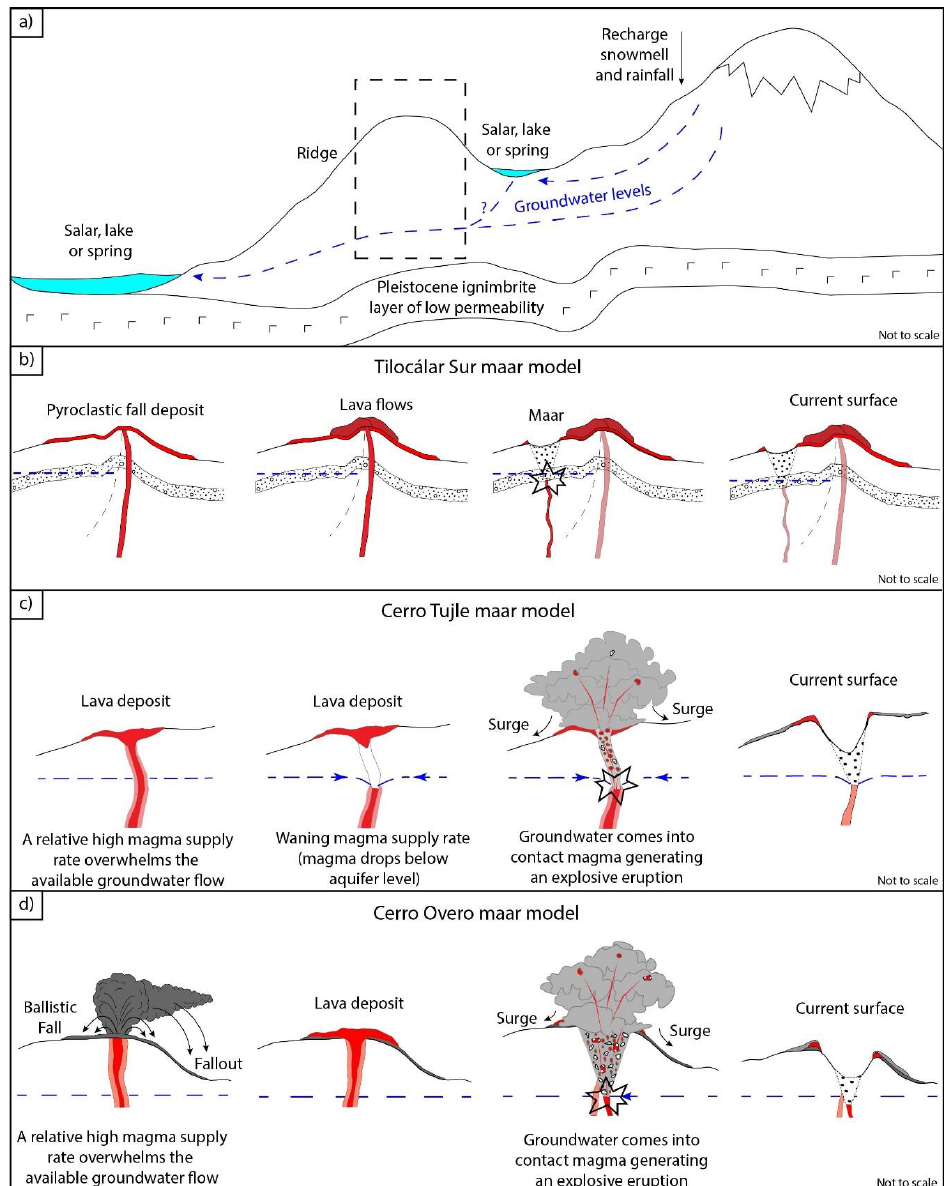
Figure 10. Proposed model of the mechanism of maar development. ( a ) Lithological and hydrogeological factors that favor phreatomagmatism in northern Chile (modified after [87,88]). The inserted box corresponds to Figure 10b–d, respectively. ( b – d ) Mechanisms of magma–water interaction for maars in northern Chile (model based on [50,53,54]).